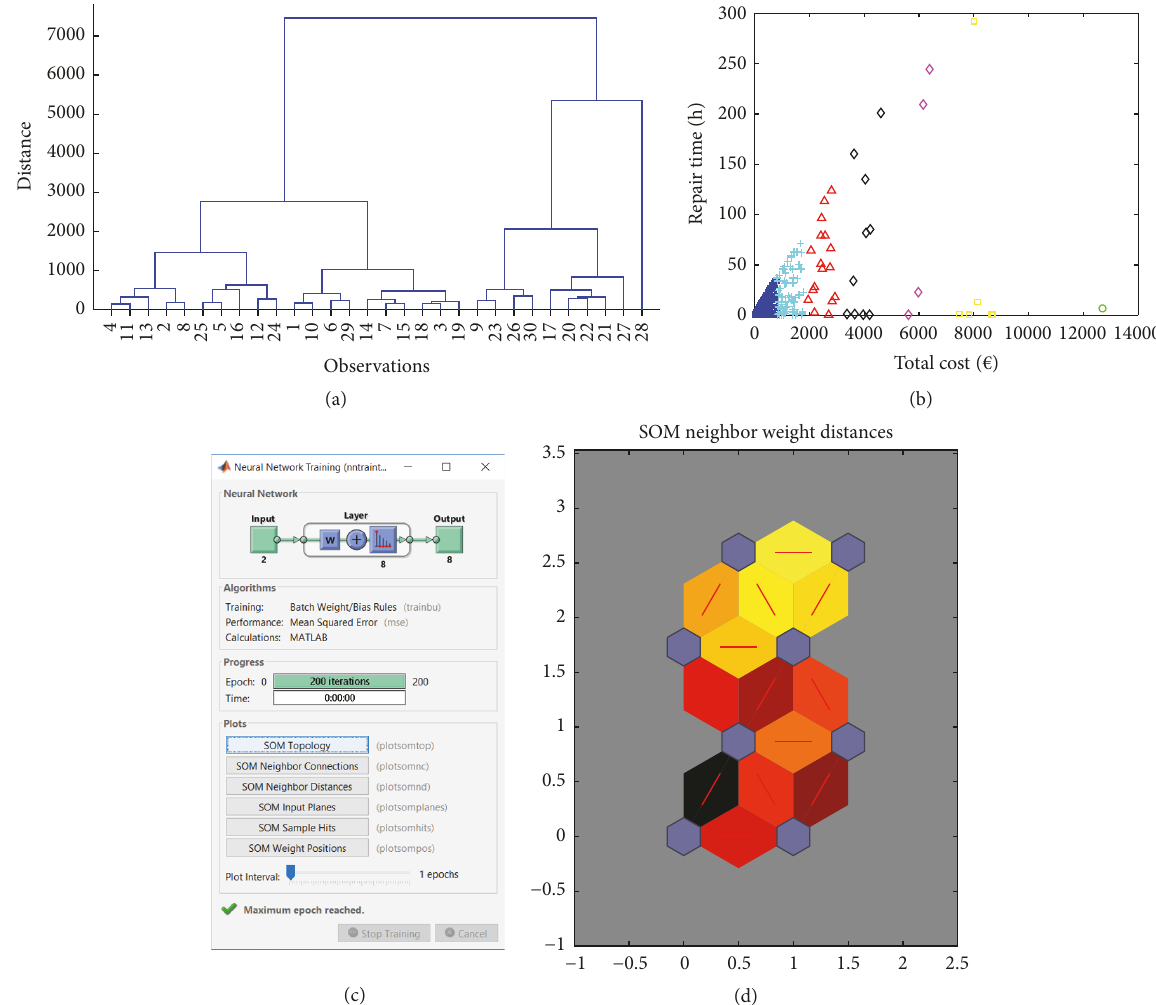
Figure 5: (a) Dendrogram; (b) data; (c) ANN SOM trained; (d) SOM